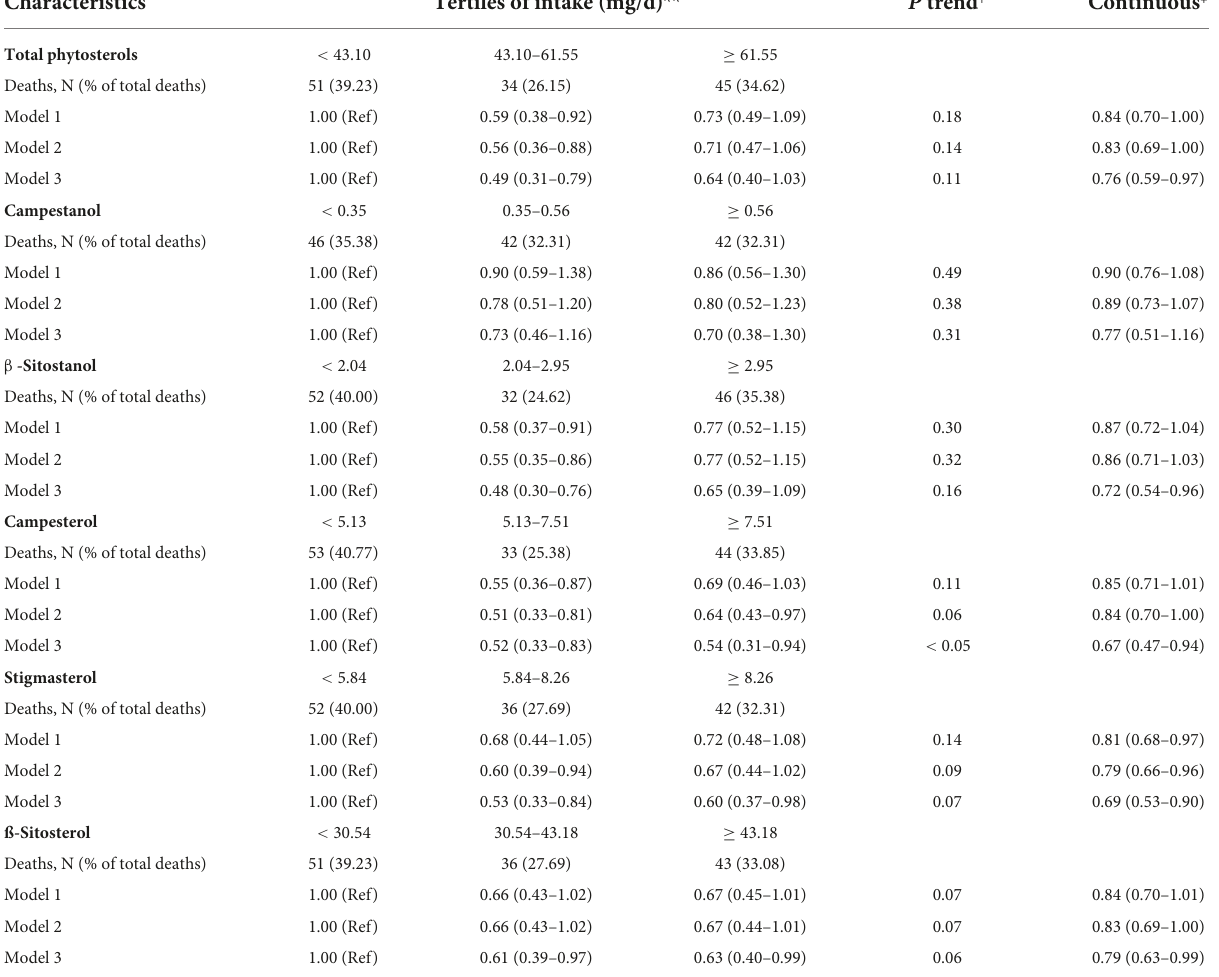
TABLE 2 Adjusted hazard ratio (HR) and 95% confidence interval (CI) for the associations of phytosterol intake with overall survival among 703 ovarian cancer patients*.